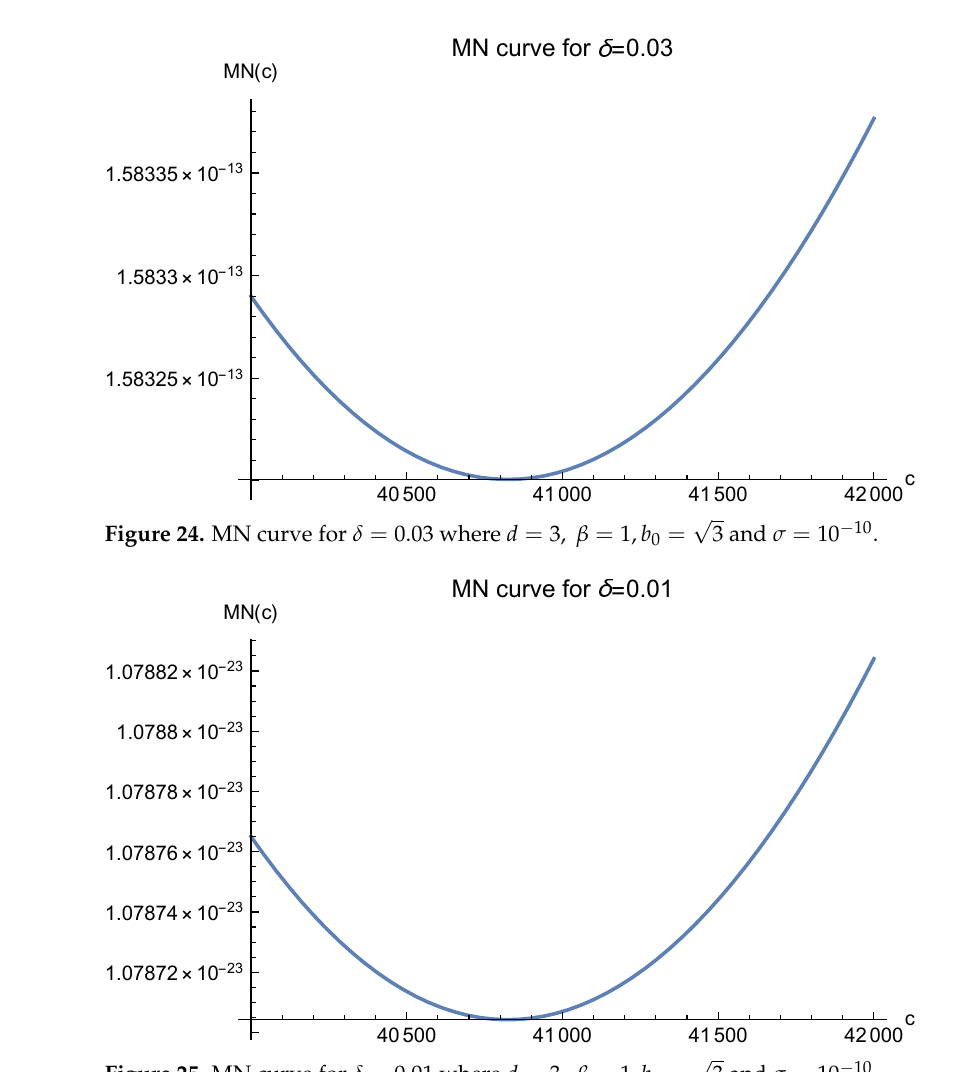
Figure 25. MN curve for δ = 0.01 where d = 3, β = 1, b 0 = Table 4. 3D experiment, c = 20.7846, b 0 =